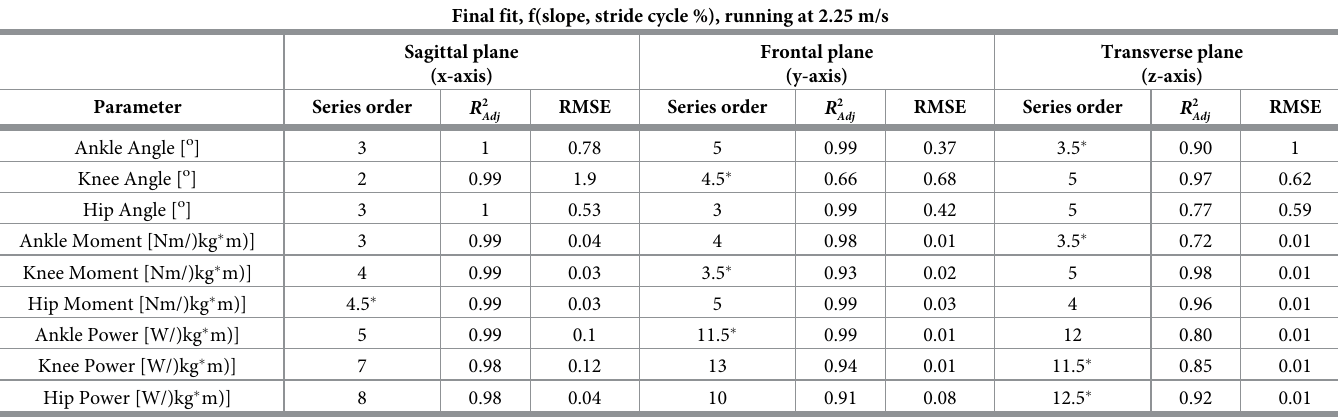
Table 3. Evaluation of the final fit (Stage 2) equations for each lower-limb joint variable, averaged on surface gradients, for running at 2.25 m/s.